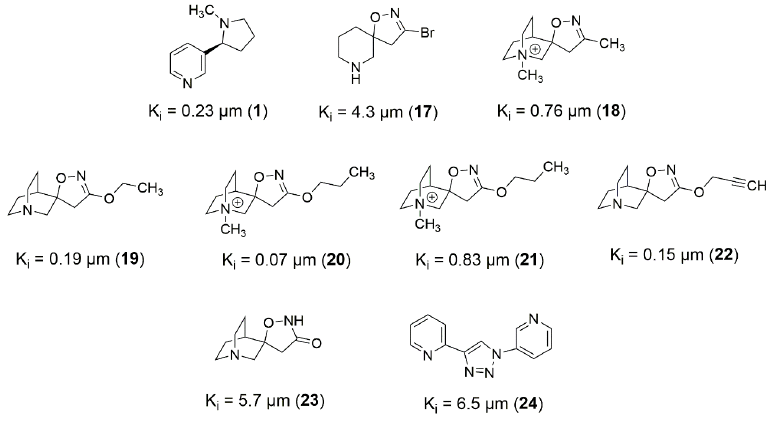
Figure 9. 2D structures for the most well ‐ behaved ligands used for α 7 receptor pharmacophore mapping.